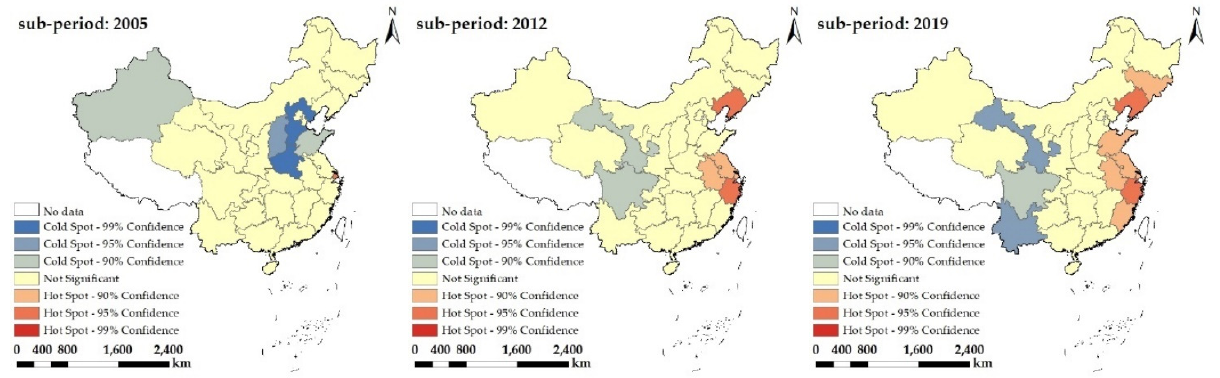
Figure 7. The cold versus hot spot space development on coordination level concerning farmland transfer and CLGUE in China.